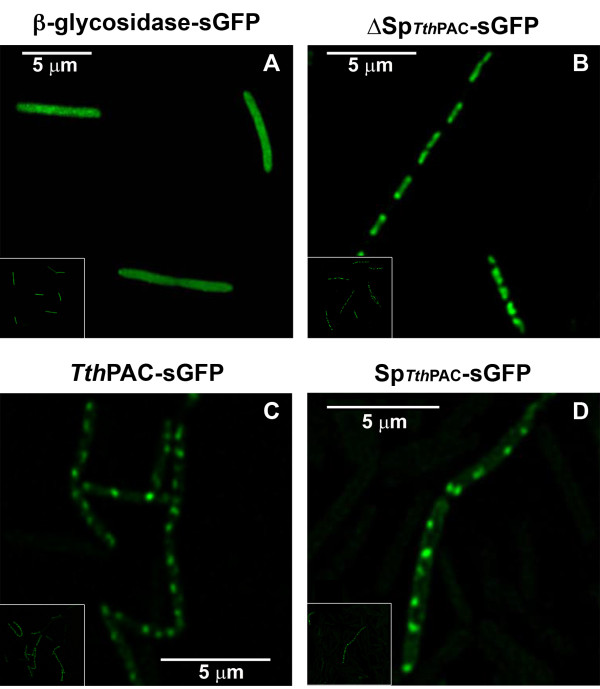
 Tth PAC subcellular location. Fluorescence confocal microscopy images were taken from exponential cultures of Tth HB27 Δpac mutant strain harboring β-glycosidase-sGFP (A), ΔSpTthPAC-sGFP (B), TthPAC-sGFP (C) or SpTthPAC-sGFP (D) protein fusions.